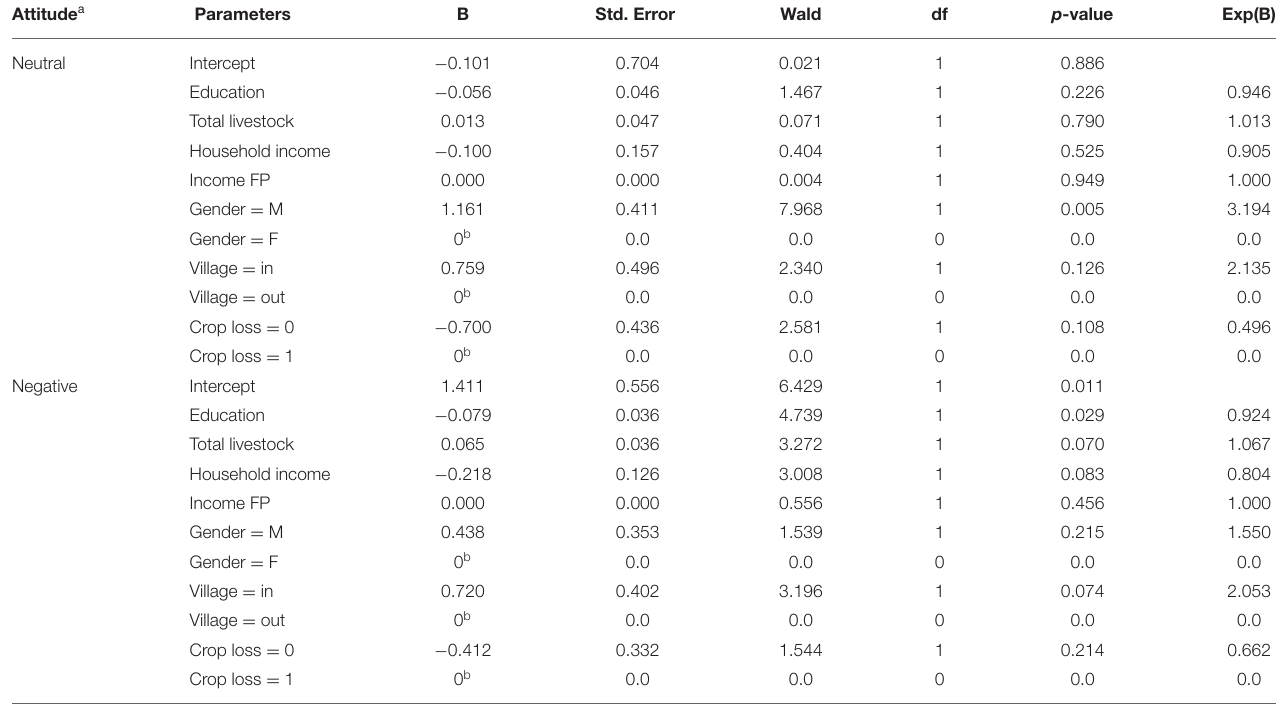
TABLE 3 | Multinomial logistic regression model explaining the attitude of people towards tiger in Panna Tiger Reserve: parameter estimates. Attitude a Parameters B Std. Error